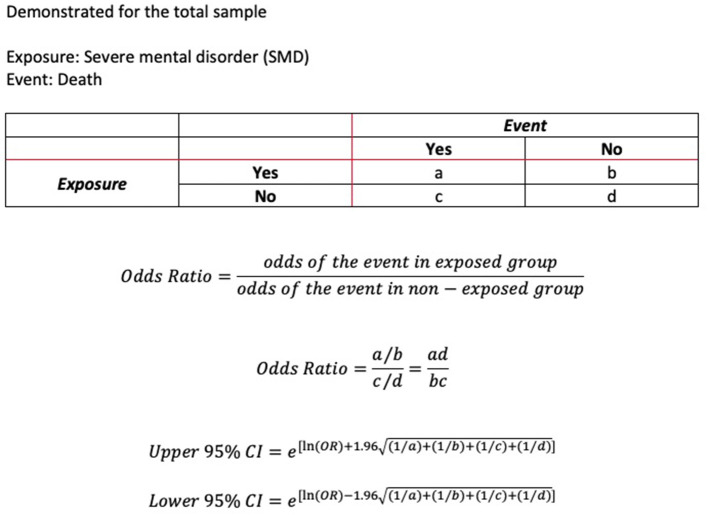
Method for calculation of odds ratios and 95% confidence interval.